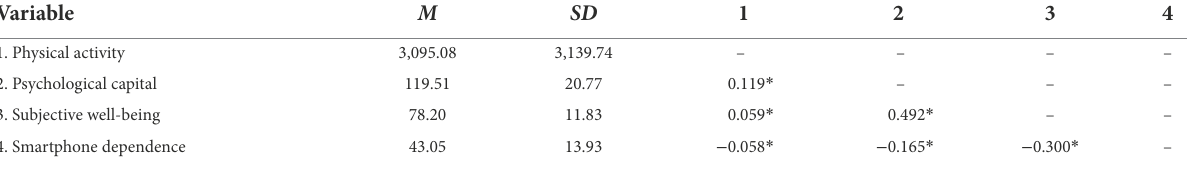
TABLE 3 Correlation analysis between